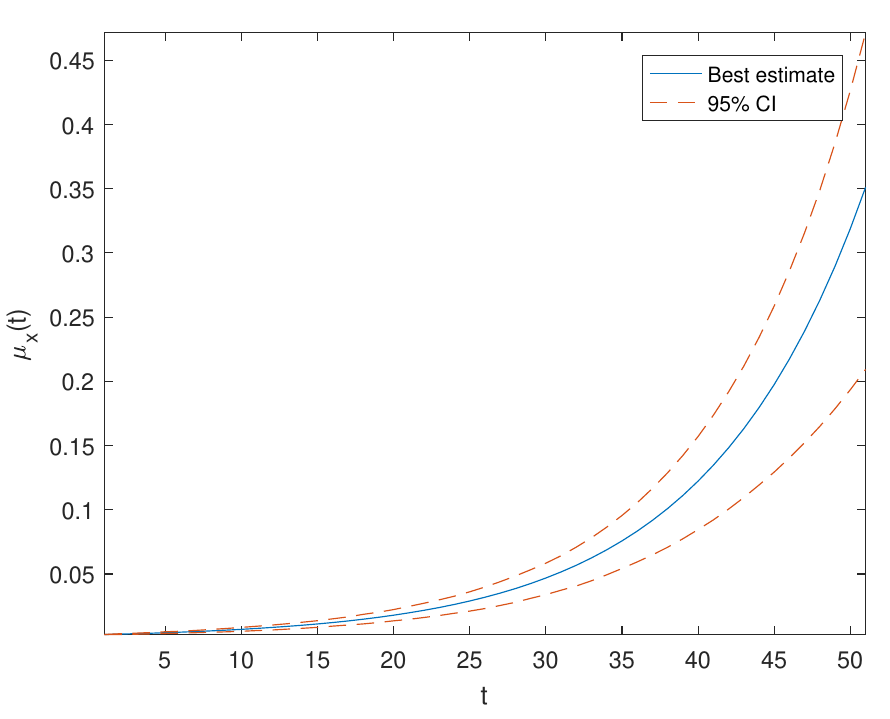
Figure A1. Simulated Force of Mortality From 2014.